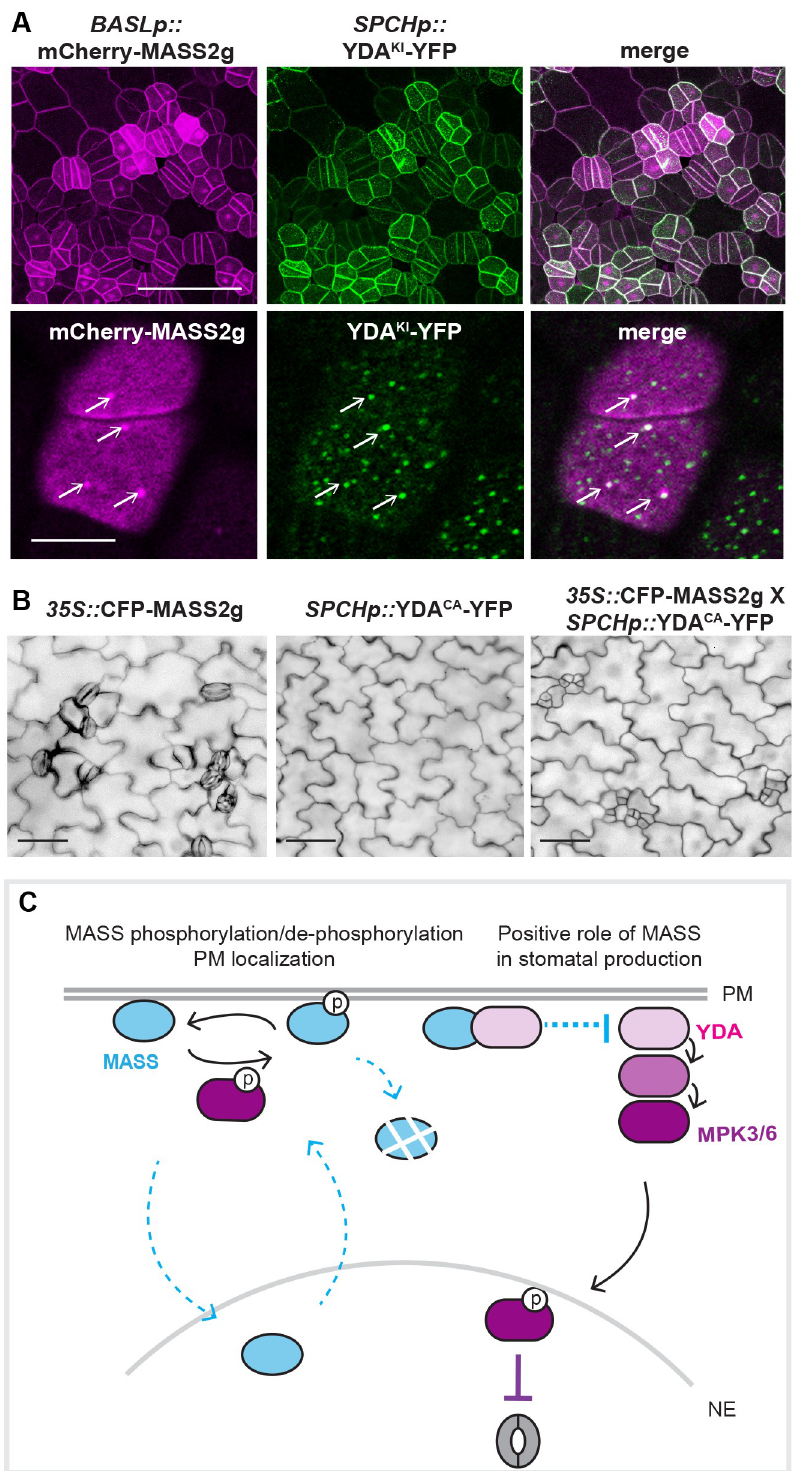
Fig 7. Working model for MASS function in stomatal development. (A) Confocal images showing co-localization of BASLp ::mCherry-MASS2g with SPCHp ::YDA KI -YFP in Arabidopsis. Bottom panels showing zoomed-in images for protein co-localization. White arrows indicate where co-localizations were found. Scale bars represent 50 μ m in the upper panel and 10 μ m in the lower panel. (B) DIC images of 5-dpg seedlings showing stomatal phenotypes